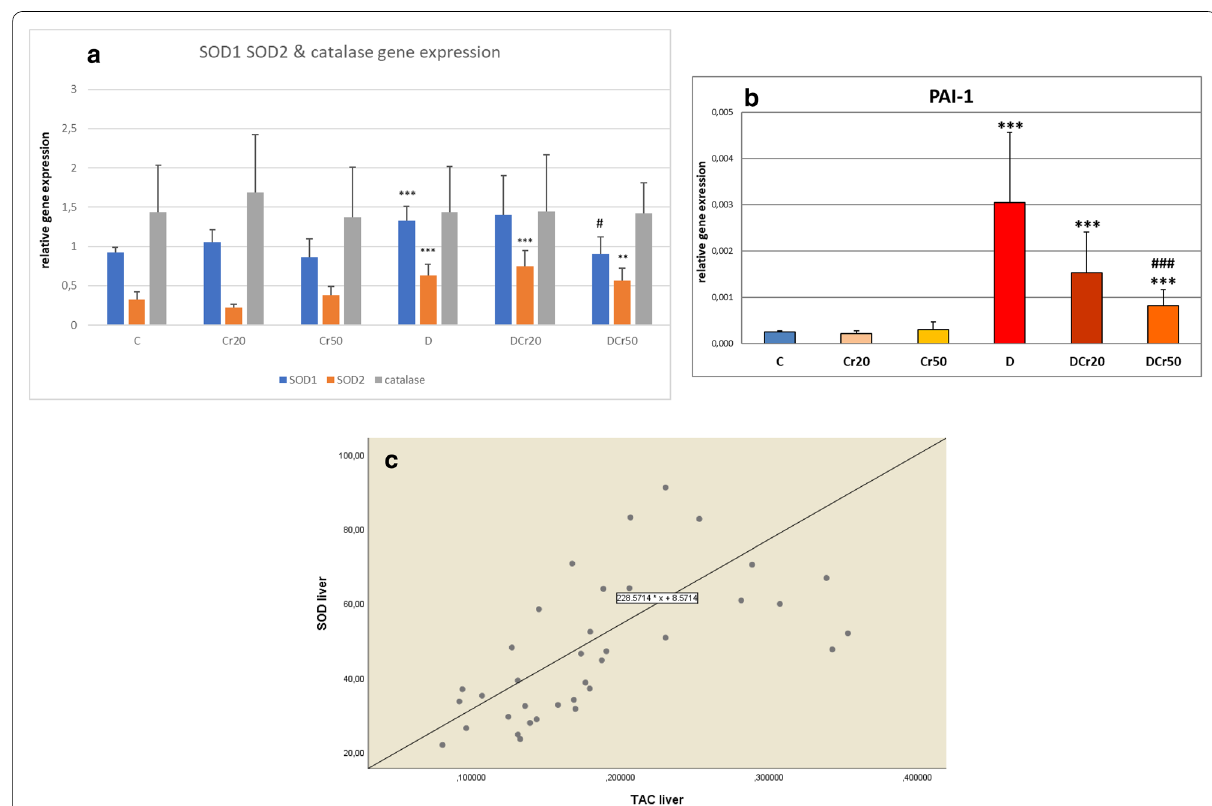
Fig. 3 a Gene expression of SOD1, SOD2 and catalase in the liver (mean SD). Double asterisk ( p < 0.01) and triple asterisk ( p < 0.005) denote ± statistically significant difference compared to the C group, # Statistically significant compared to the D group ( p < 0.05). b Gene expression of PAI-1 gene in the liver (mean SD). The triple asterisk ( p < 0.005) denotes a statistically significant difference compared to the C group; ### Statistically ± significant compared to the D group ( p < 0.005). c The strong correlation between SOD activity and TAC in liver (r s 0.732, p < =